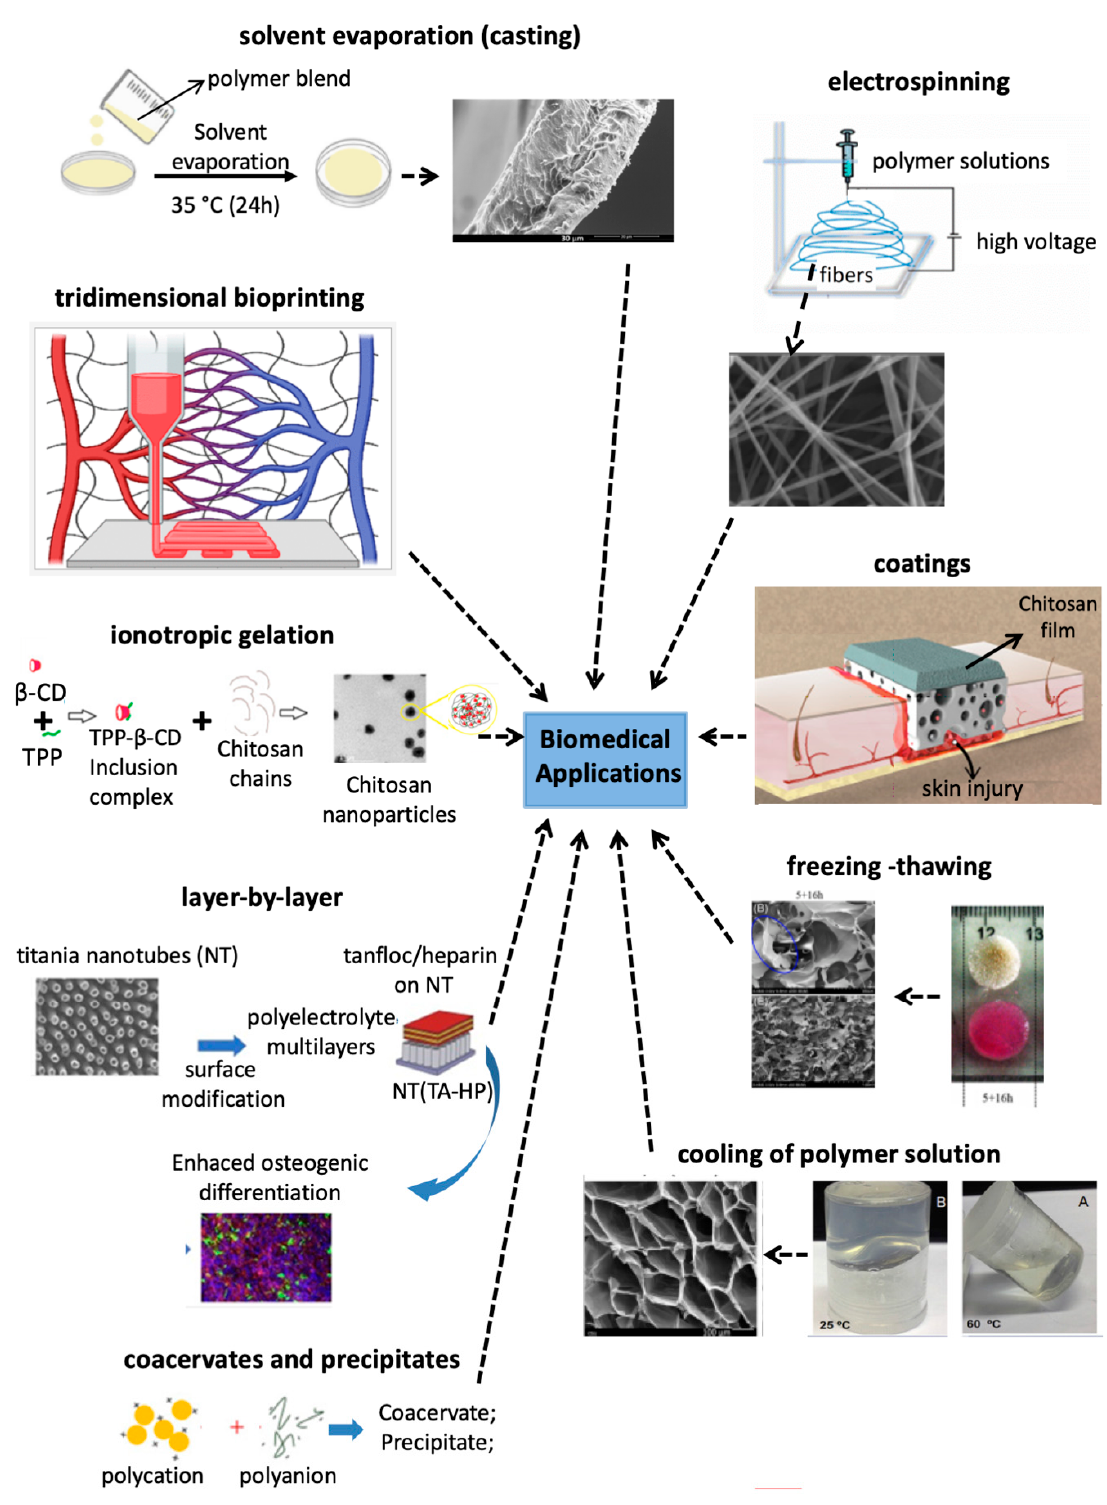
Figure 8. Principal strategies used to create polysaccharide-based materials by physical association for biomedical applications. Adapted with permission from References [139–145]; published by Elsevier, 2019, 2020, 2018, 2020, 2020, 2010, and 2020, respectively. Adapted with permission from Reference [146]; published by American Chemical Society, 2020. Adapted from the References [147,148]; published by Wiley, 2019 and 2020. TA = polyphenolic tannin derivative, commercially called Tanfloc; HP = heparin; β -CD = β -cyclodextrin; and TPP = tripolyphosphate.